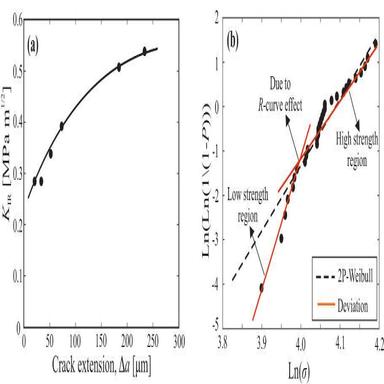
(a) Fracture resistance, KIR and (b) Weibull plot of Leucite-based dental porcelain.